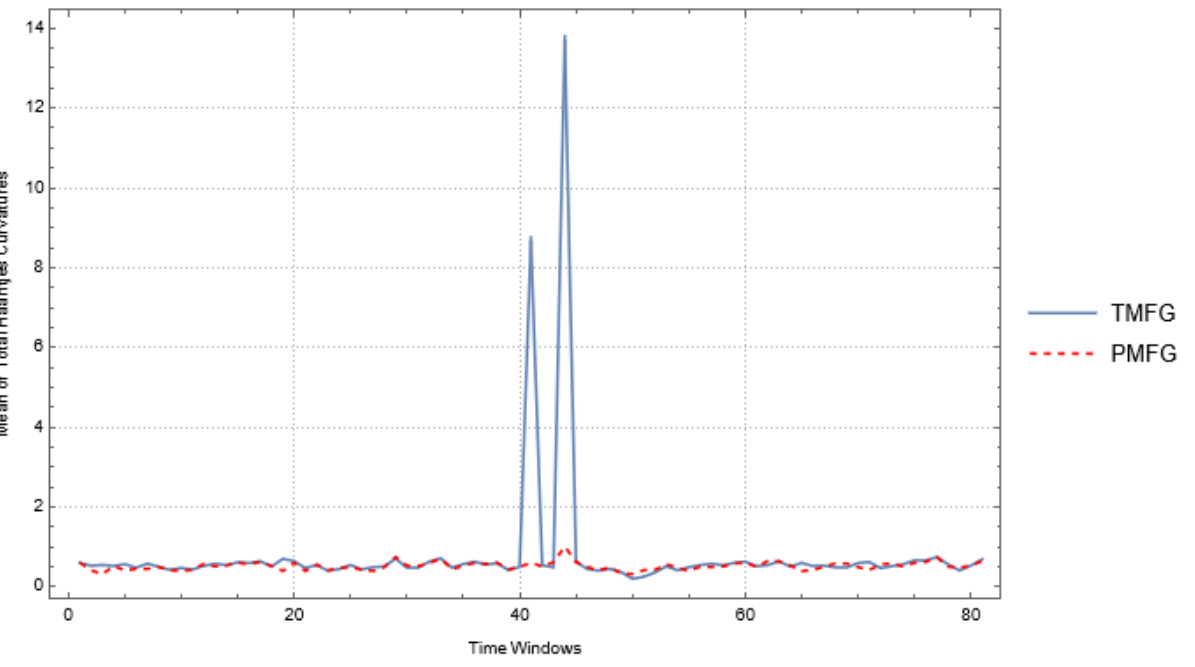
for BIST using TMFG and PMFG T